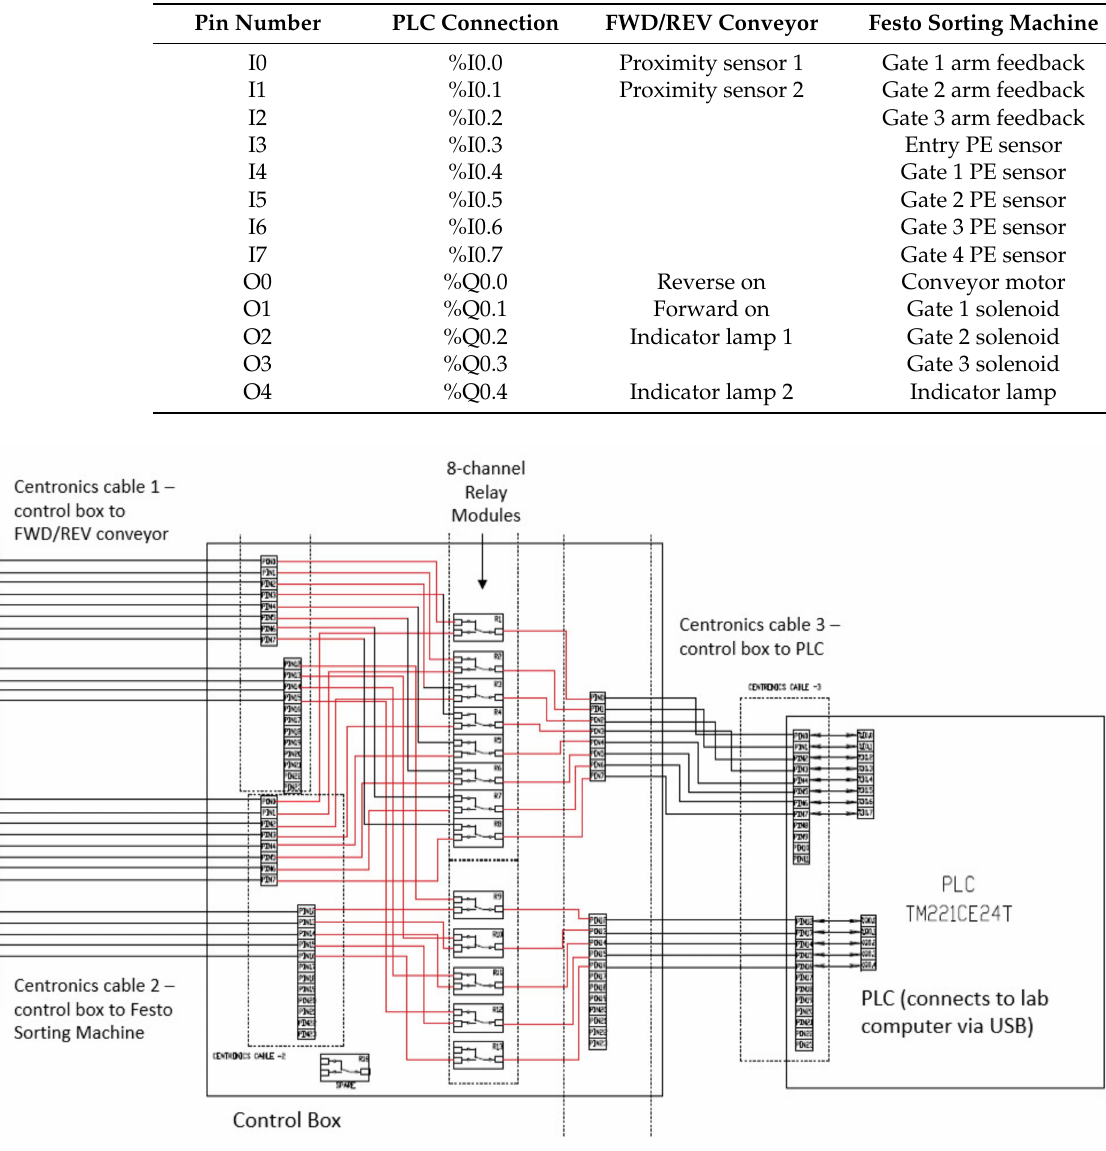
Table 1. Input output usage of the Centronics cable.